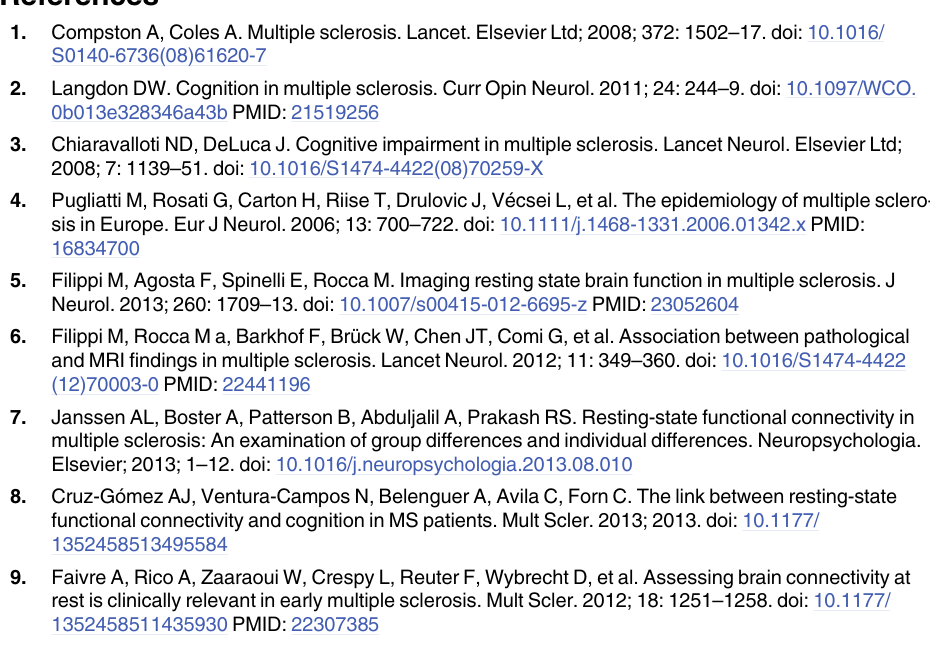
S1 Fig. Group functional connectivity maps of all networks. S1 Fig illustrates all nine net- works at baseline (BL) and follow-up (FU) for both groups. Tfce corrected p-values > 0.99. HC = Healthy controls, MS = patients with